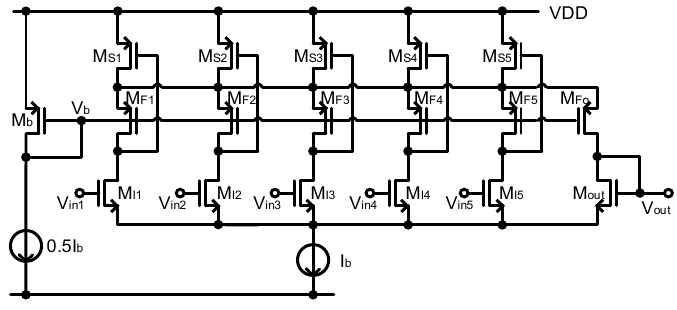
Figure 7. The voltage-mode MAX circuit.